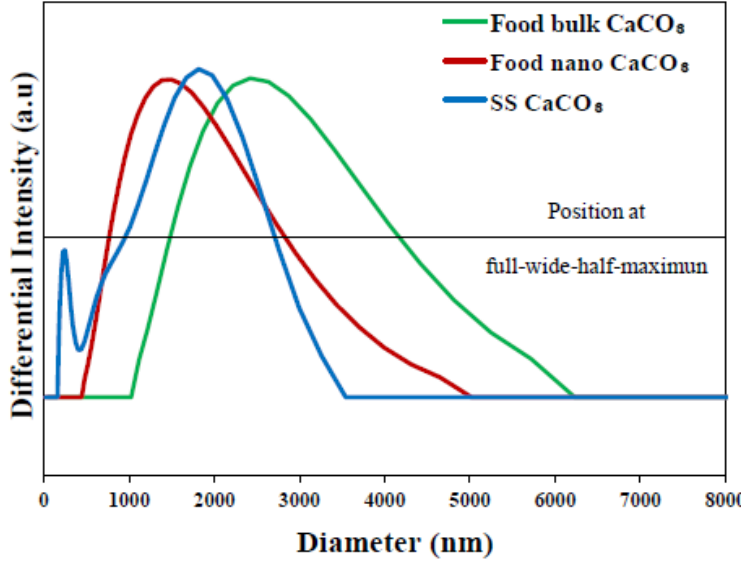
Figure 2. Hydrodynamic diameter of food bulk CaCO 3 (dashed line), food nano CaCO 3 (solid line) and SS CaCO 3 (dotted line) as a function of differntial intensity. Horizontal line stands for the position of full-width at half-maximum to evaluate peak